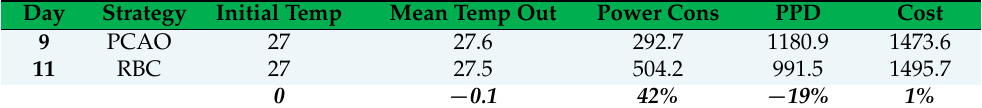
Table 6. Comparison between the PCAO (9th) and the RBC (11th) summer days.